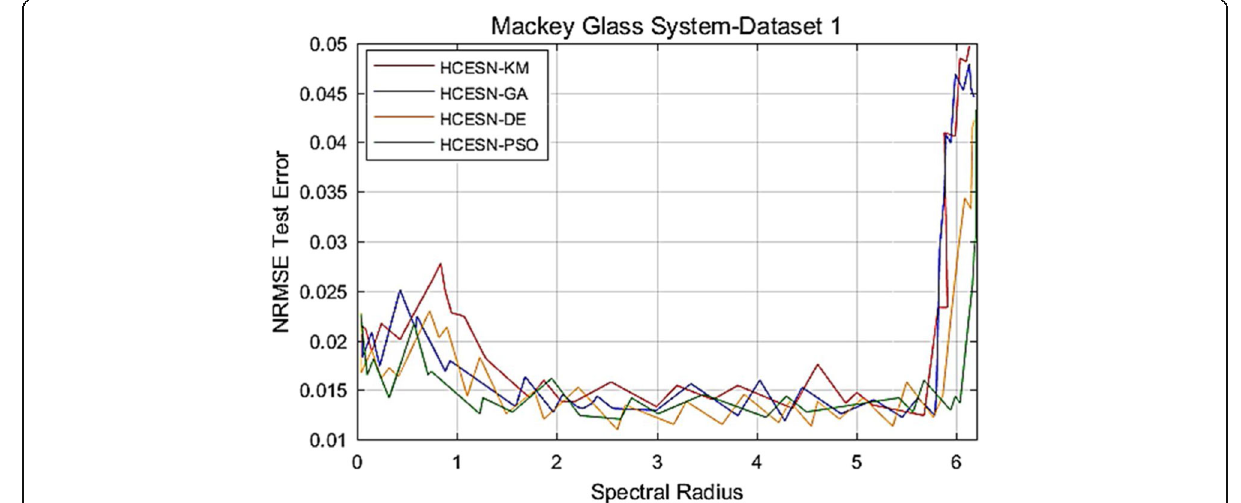
Fig. 4 NRMSE84 test error on dataset 1